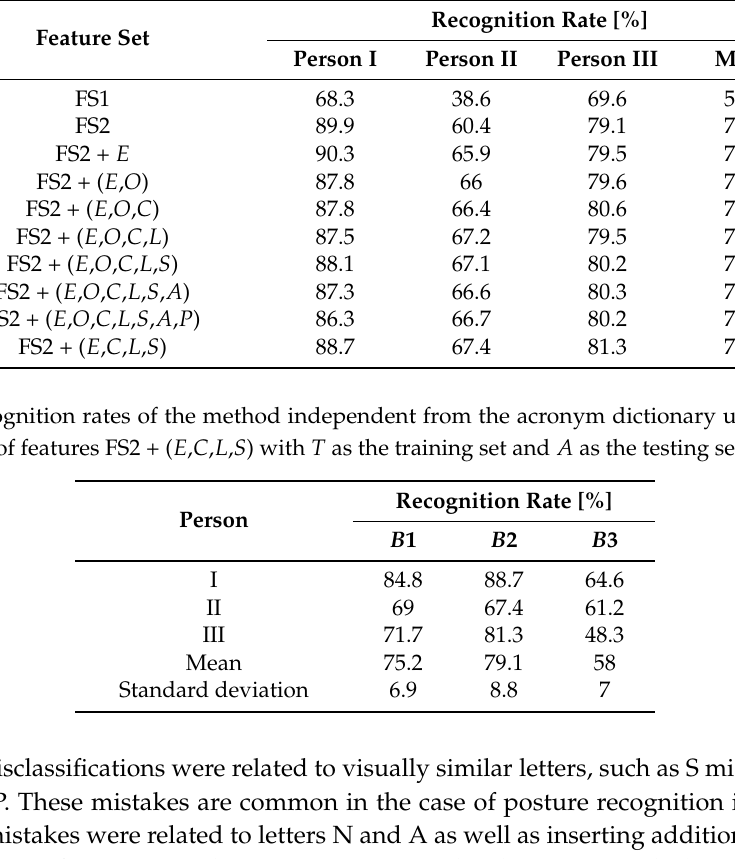
Table 3. Recognition rates of the method independent from the acronym dictionary using different combinations of features. The results were obtained for the model B 2 with T as the training set and A as the testing set.